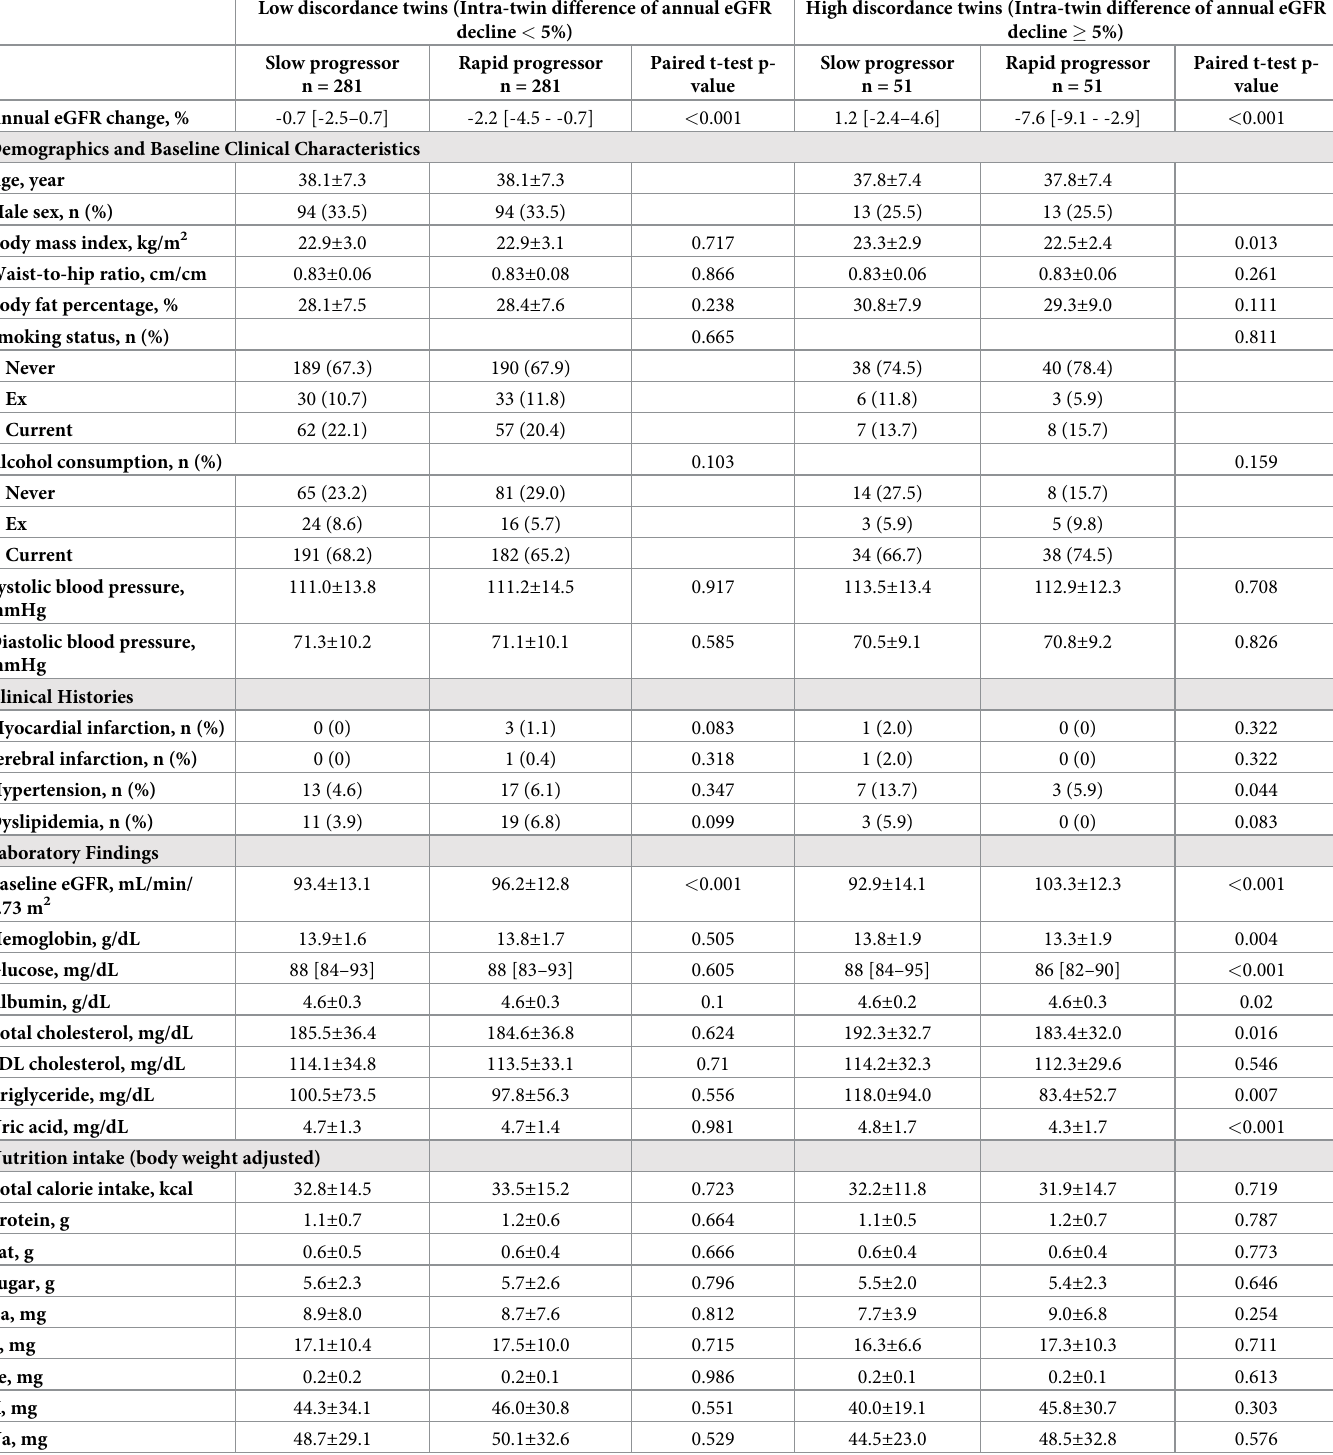
Table 1. Comparison of baseline characteristics between slow and rapid eGFR progressor in twins stratified by high or low discordance of eGFR decline